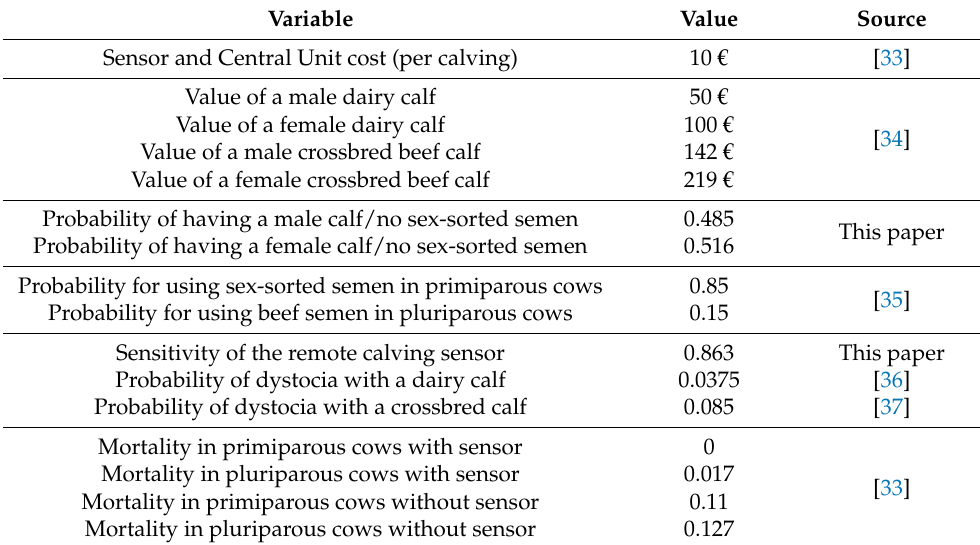
Table 1. Market prices and epidemiology parameters applied in the decision-tree analysis. Variable Value Source Sensor and Central Unit cost (per calving) 10 € [33] Value of a male dairy calf 50